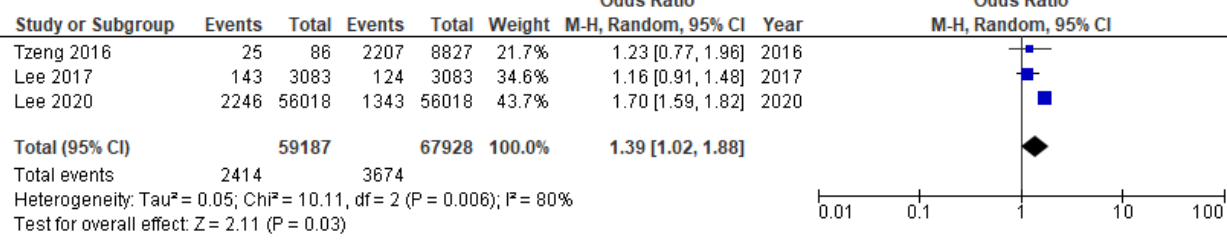
Figure 8. Sensitivity post-hoc analysis to determine the robustness and consistency of main meta- analysis results [134–136]. Forest plot for the association between periodontitis and dementia (primary outcome) in three cohort studies.